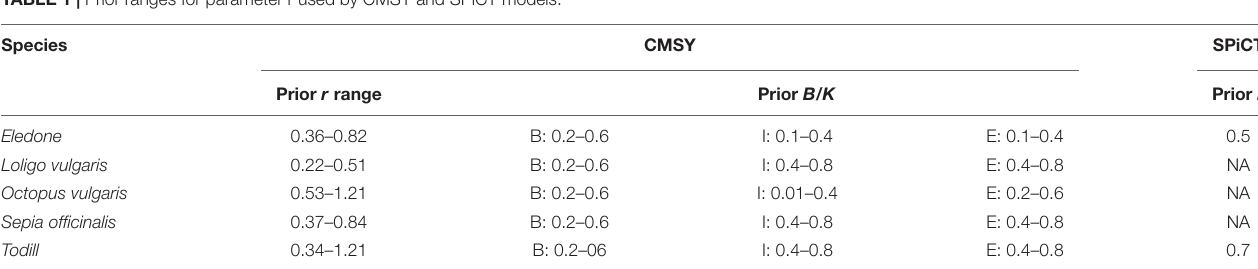
FIGURE 1 | Geographical Sub-Area 16, south of Sicily, where the data of the considered cephalopods were collected. TABLE 1 | Prior ranges for parameter r used by CMSY and SPiCT